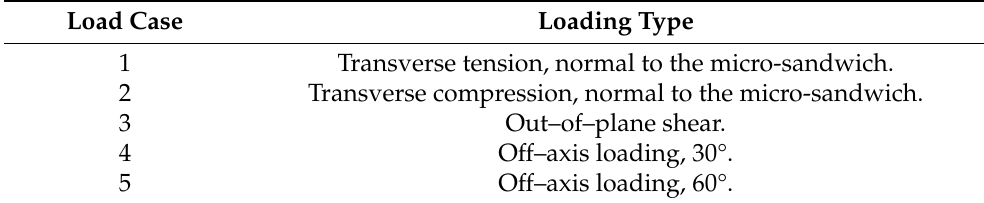
Table 2. The load cases used in the present study are summarized in the table.